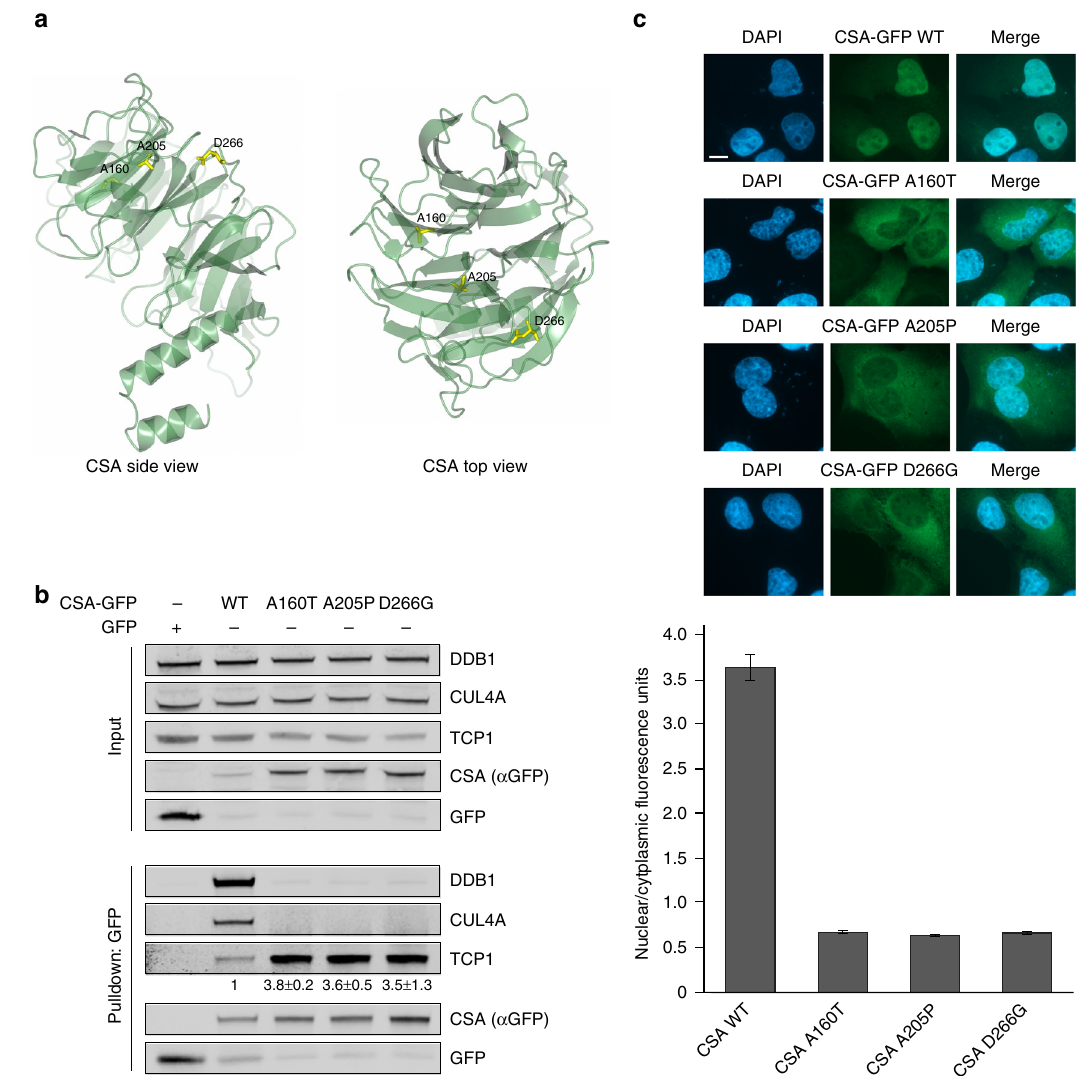
Fig. 7 Patient mutations in CSA cause increased TRiC binding. a Side and top view of CSA. Residues Ala160, Ala205, and Asp266 that have been found mutated in Cockayne syndrome patients are shown in yellow. Visualization was done in ccp4mg using structure 4a11 from the PDB. b CSA harboring patient mutation A160T, A205P, or D266G shows increased binding to TRiC and failure to be incorporated into the CRL CSA complex. CSA-GFP WT and CSA-GFP containing the indicated mutations were pulled down from U2OS cells. Protein levels were determined by western blot analysis. The signal intensity ratio of TCP1 over the CSA-GFP mutant relative to that of TCP1 over CSA-GFP WT, which was set to 1, is shown as the mean ± SEM of two independent experiments. c CSA A160T, A205P, and D266G show predominant cytoplasmic localization. CSA-GFP WT and CSA-GFP containing the indicated mutations were expressed in U2OS. Mean nuclear and cytoplasmic GFP intensities were analyzed and quanti fi ed by fl uorescence microscopy and ImageJ. For each cell, the nuclear/cytoplasmic ratio was calculated. Data represent mean ± SEM of 100 cells quanti fi ed in two independent experiments. Length of scale bar: 10 µ m. Full-size scans of western blots are provided in Supplementary Fig.